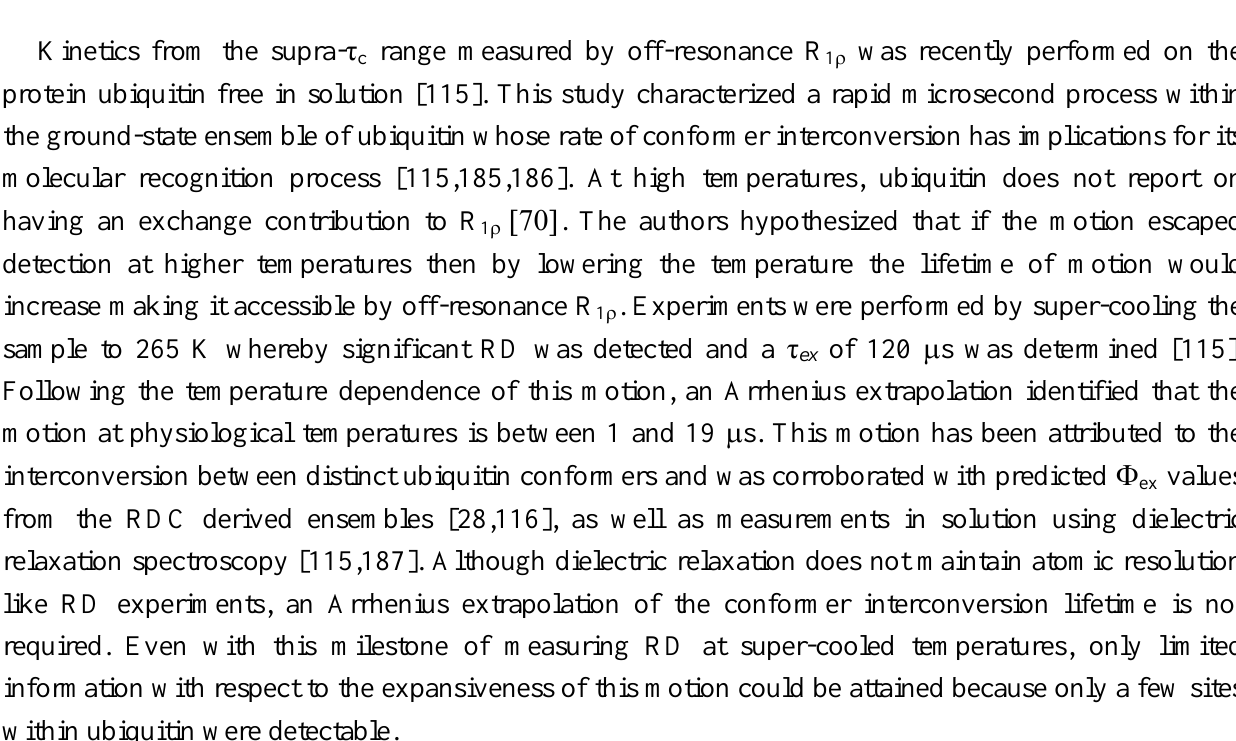
monitored by R (solid black line) and CPMG ex 1  , p , and  , were set to ex B